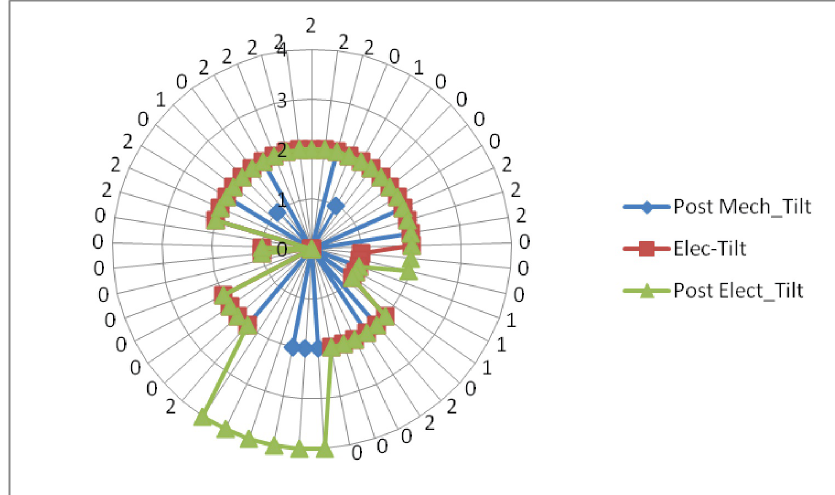
Figure 10. Signal control analysis with electrical and post-electrical to control the phase of signal and post-mechanical tilt to control the overall segments and coverage